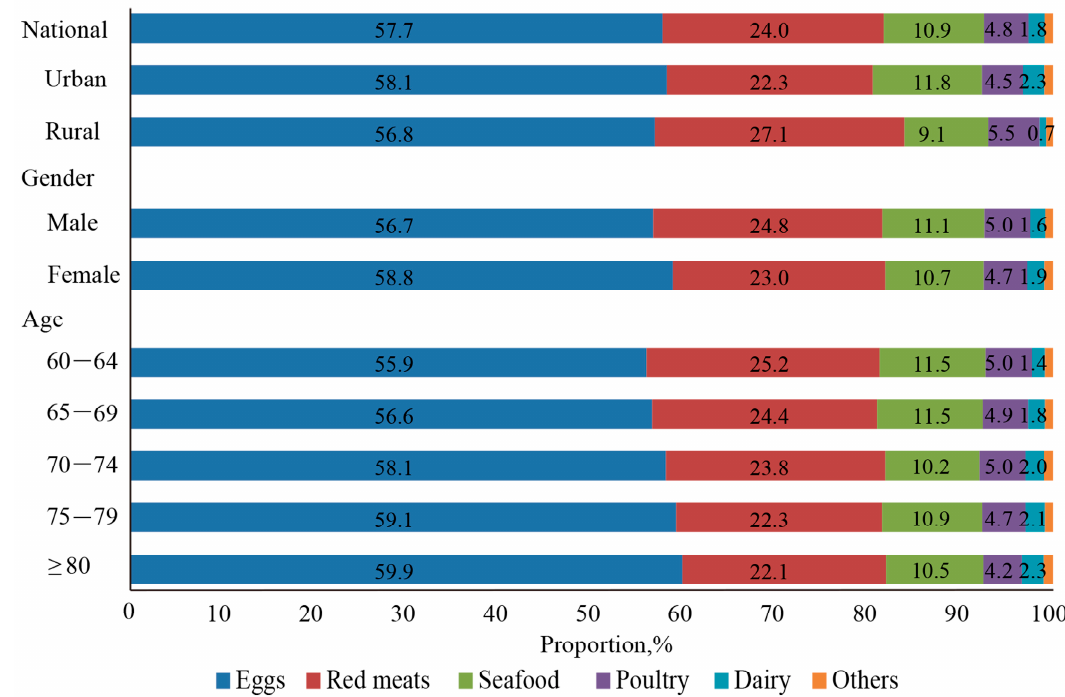
Figure 1. Food sources of dietary cholesterol among the Chinese elderly population by age, gender and residence.